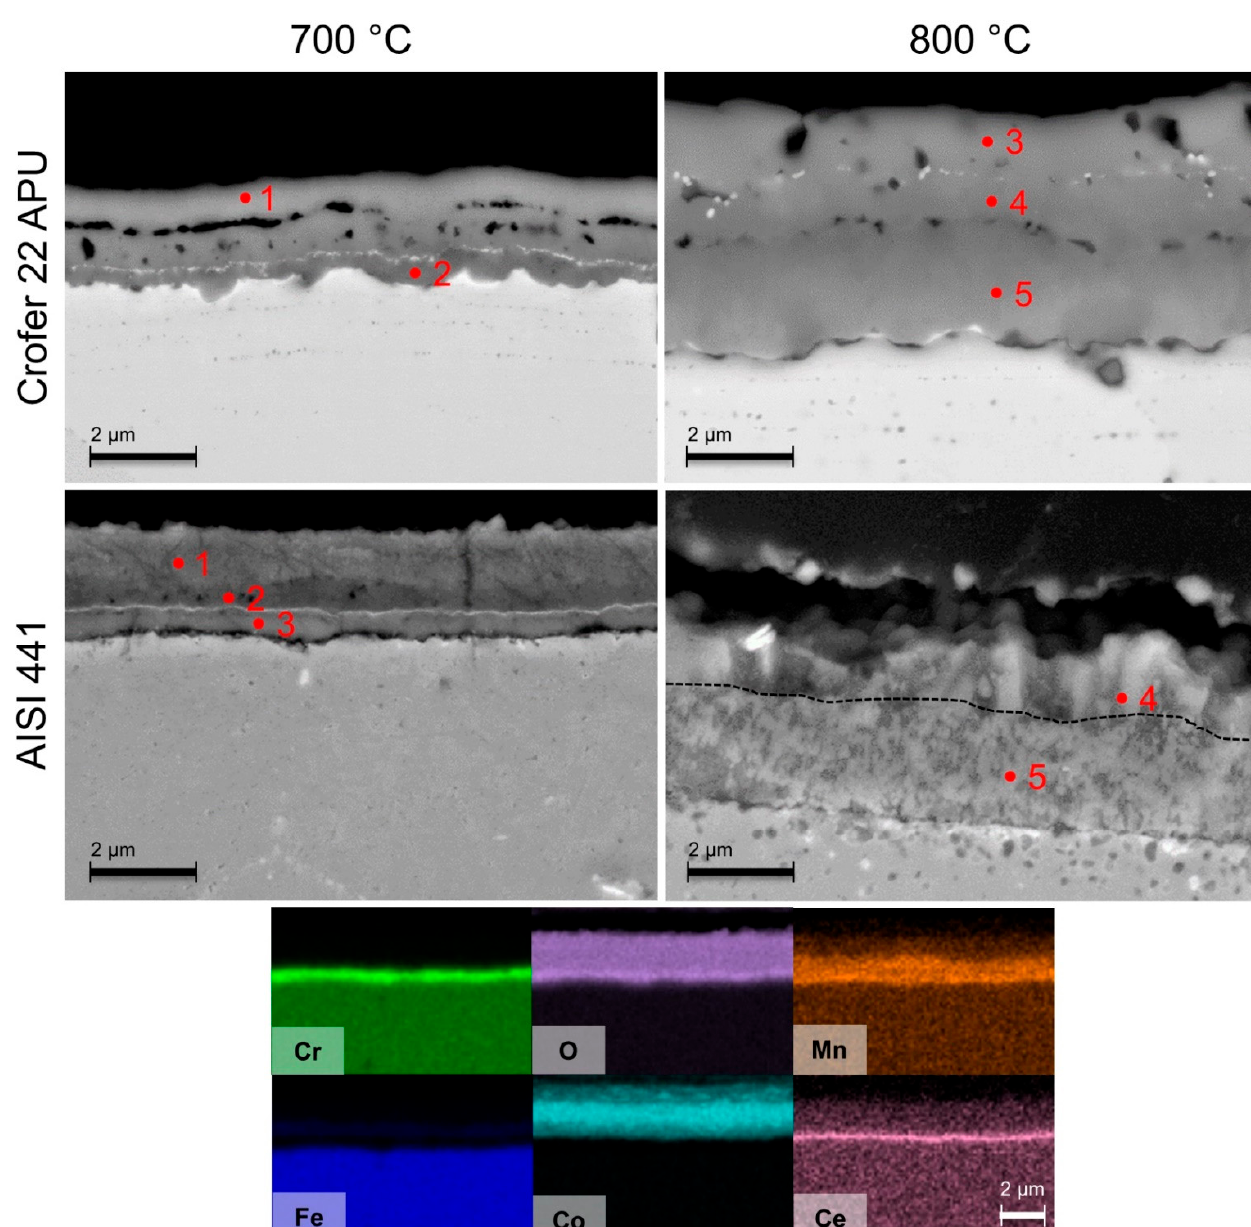
Figure 9. Ce/Co coated Crofer 22 APU ( upper ) and AISI 441 ( lower ) after 1500 h at 700 °C ( left ) and at 800 °C ( right ) in oxidizing atmosphere. The dashed line approximately shows the interface between the Cr 2 O 3 oxide scale and the (Cr,Mn)-spinel oxide on the picture at 800 °C for AISI 441 (bottom right). EDS point analysis was conducted from the spots indicated by red markers. The compositions in these spots are given in Table 5. The EDS maps on the bottom are for Ce/Co coated AISI 441 at 700 °C.